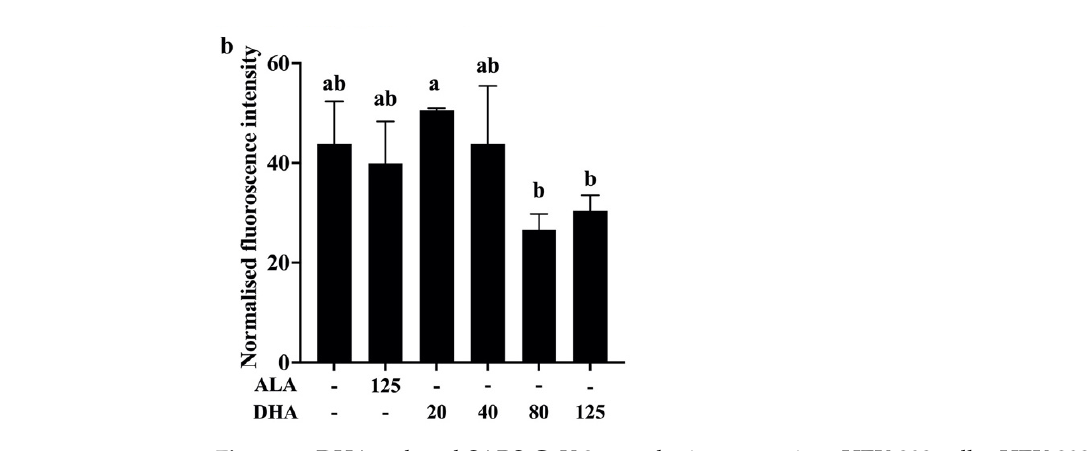
Figure 4. DHA reduced SARS-CoV-2 pseudovirus entry into HEK 293 cells. HEK 293 cells were treated with ALA or DHA at the indicated concentrations (µM) for 16 h before transduction for 24 h with baculovirus pseudotyped with original SARS-CoV-2 spike protein (PV) to deliver a green fluorescent reporter into the cell nuclei. Before imaging, the cell nuclei were stained with Hoechst 33342 as a control for live cell density: ( a ) Representative fluorescent images of the treated cells. Brightness and contrast were adjusted for visualization purposes to ensure the same level was main- tained across the images. ( b ) Green fluorescent intensity readings of treated cells normalized to that of the Hoechst stain of live cells. Data are presented as mean ± SEM, with n = 3. In the graphs, bars not sharing a common letter are significantly different ( p < 0.05), based on an LSD post-hoc